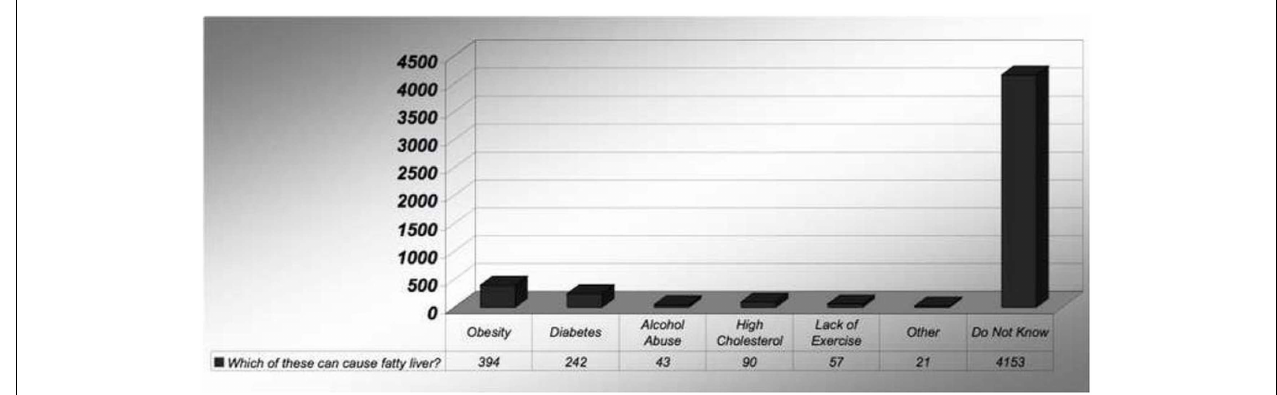
FIGURE 2 |Awareness of etiologies of NAFLD .